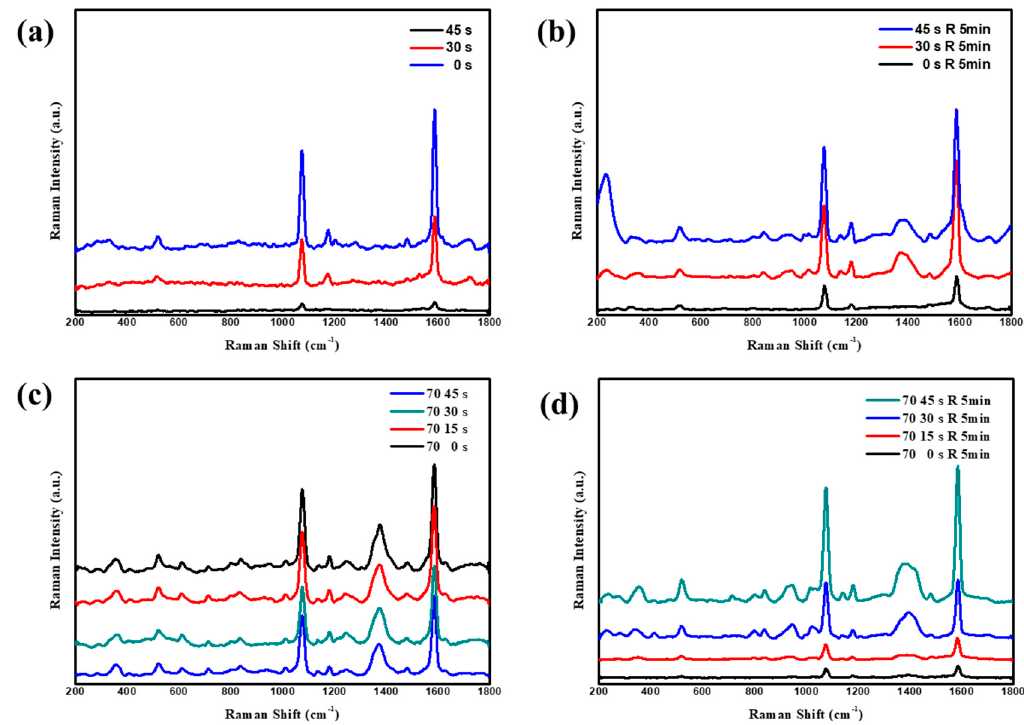
Figure 6. The nanojar structure was etched using a plasma cleaner. ( a ) Surface-Enhanced Raman Scattering spectra after etching the substrate of the nanojar array structure for 0, 15, 30, 45 s. ( b ) SERS spectra of LSPR-assisted chemical growth of silver nanoparticles for 5 min on the substrate of the nanojar array structure after etching for different times. R represents chemical reaction. ( c ) A Raman spectrum of a nanojar structure of 15, 30, 45, 60 s obliquely sputtered at 70°. ( d ) A Raman spectrum of